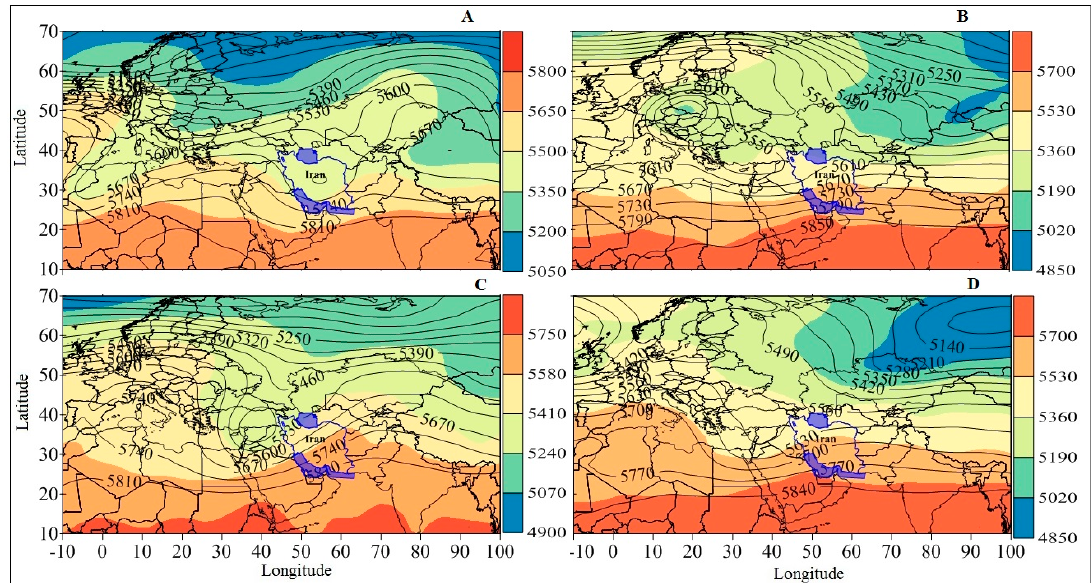
Figure 6. The thickness patterns of the Iran’s fall comprehensive precipitation; (( A ) a deep trough on the western Mediterranean; (( B ) low height system on the Europe); (( C ) two low height cores on the Mediterranean and southwestern Europe); (( D ) a ridge over the Eastern